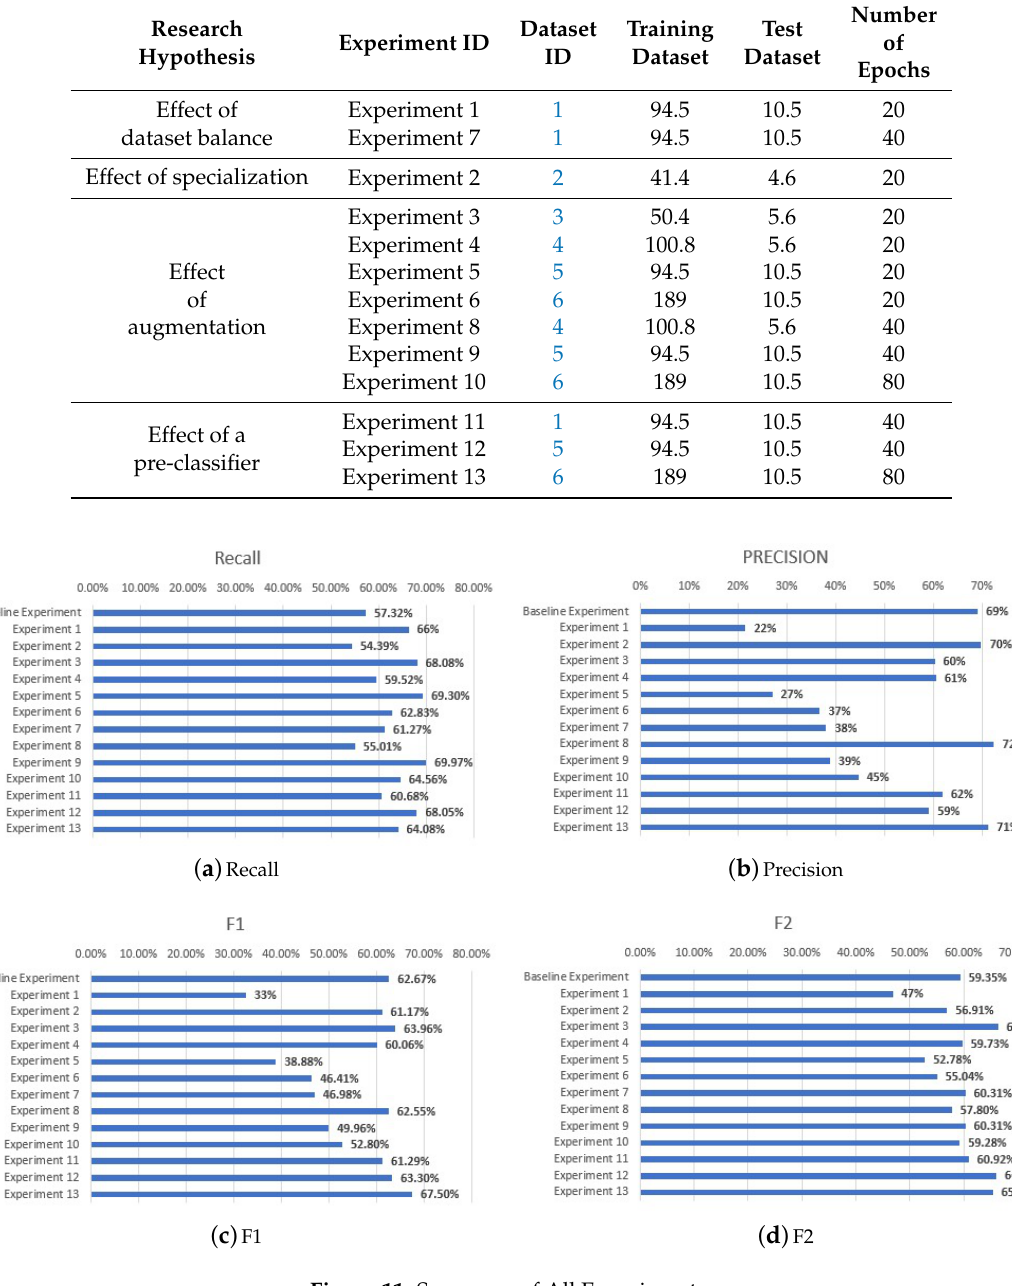
Figure 11. Summary of All